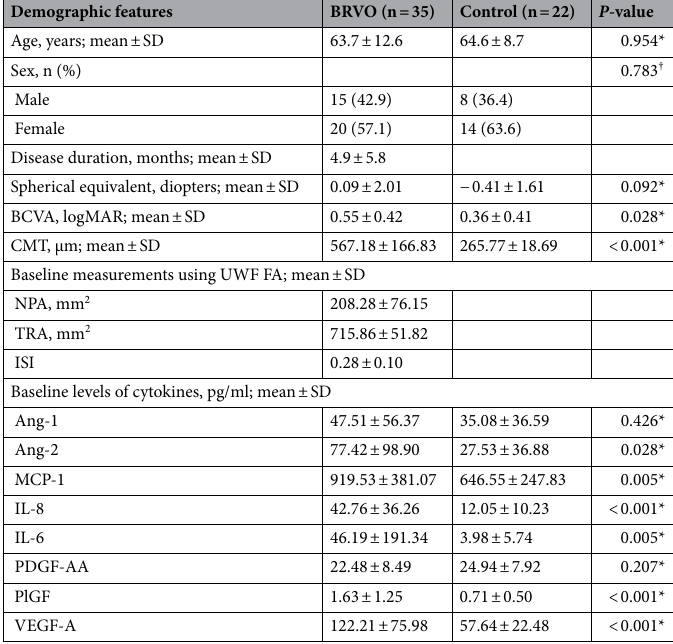
Table 1. Demographic features of patients with retinal vein occlusion and control group. BCVA: best- corrected visual acuity, BRVO: branch retinal vein occlusion, CMT: central macular thickness, ISI: